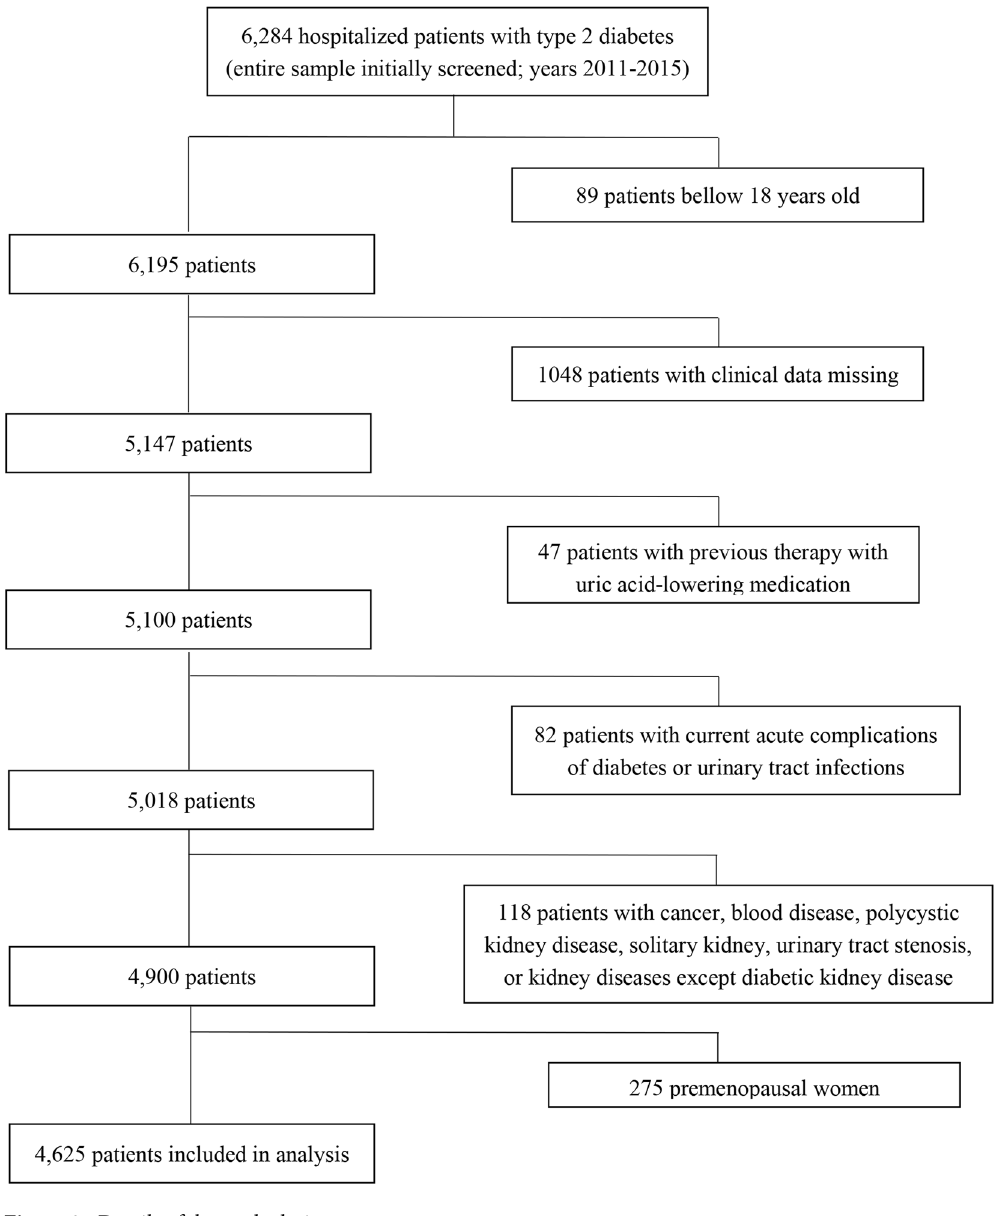
Figure 3. Details of the study